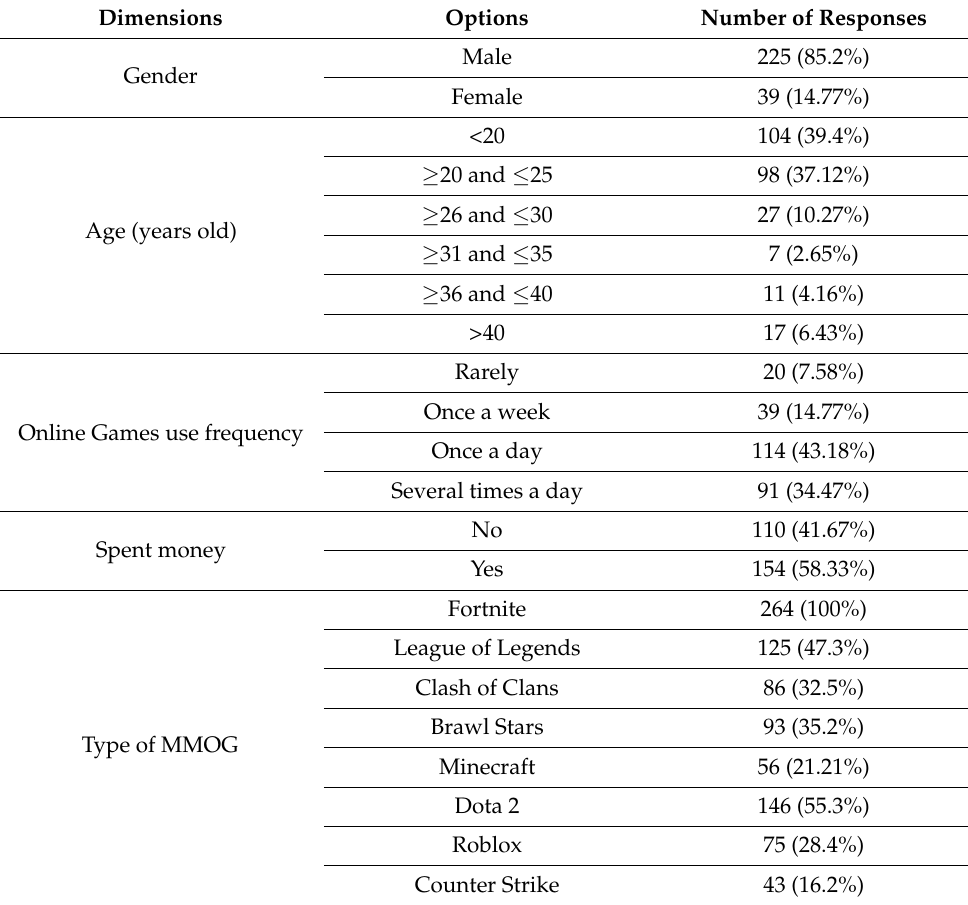
Table 1. Profile of